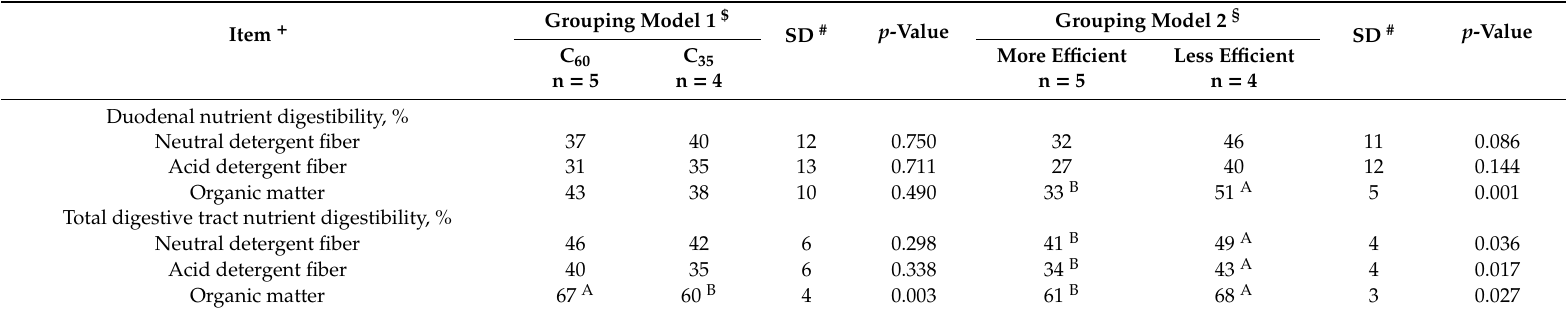
Table 9. E ff ect of concentrate feed proportion of the ration and microbial e ffi ciency (synthesized microbial crude protein / fermented organic matter) on apparent nutrient digestibility at the duodenum and the total digestive tract digestibility at faecal